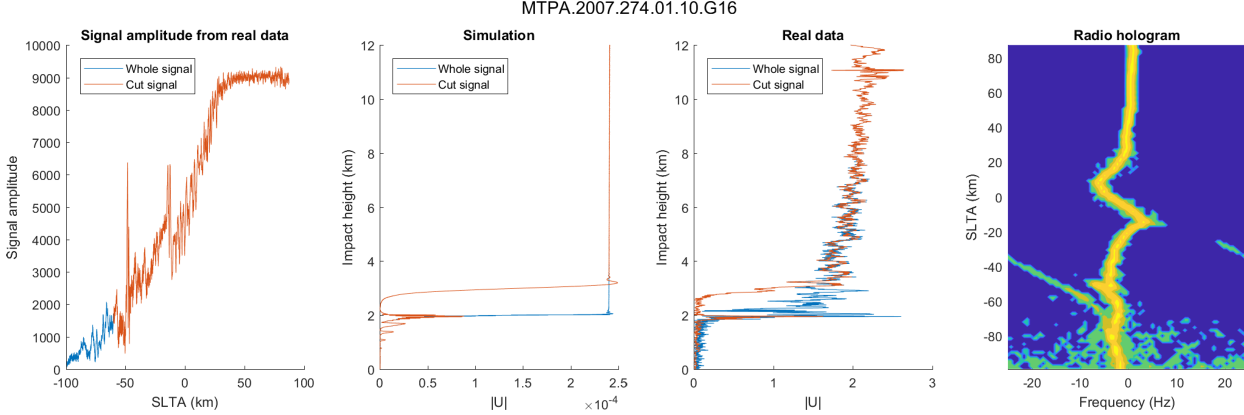
Figure 5. An event classified as category 1. SLTA min is at approximately − 86km, and the signal is truncated at SLTA = − 60km. The reflection spike is located at an impact height of 1948m, and a min is 2008m.